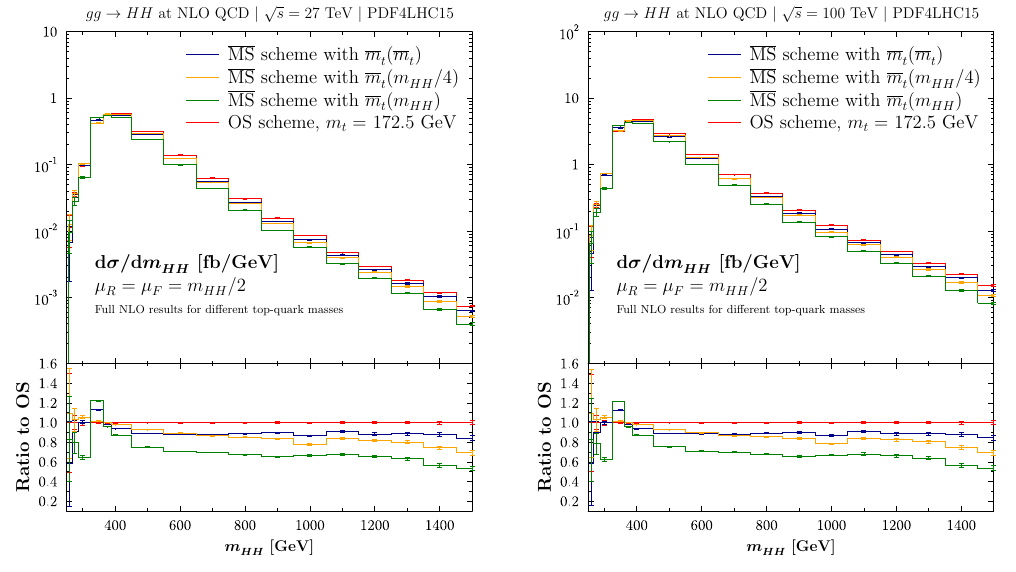
Figure 15 . Same as (cid:12)gure 14 but for c.m. energies of 27 (left) and 100 (right)